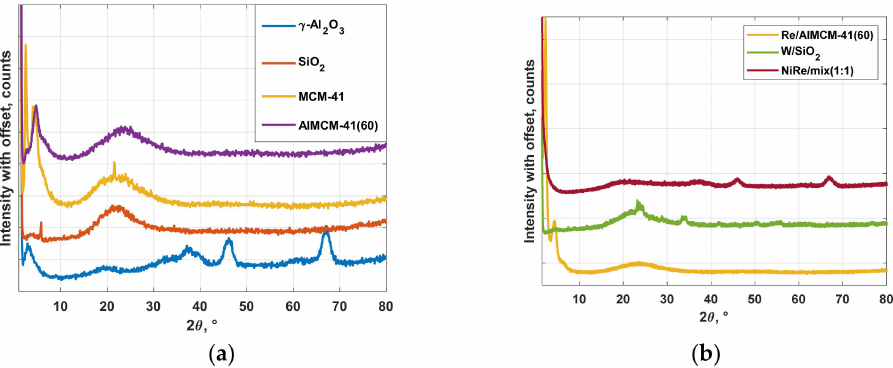
Figure 3. XRD patterns for ( a ) the applied support materials and ( b ) catalysts for the metathesis of ethene and trans-butene in the range of 2 Θ = 0–80 ◦ .